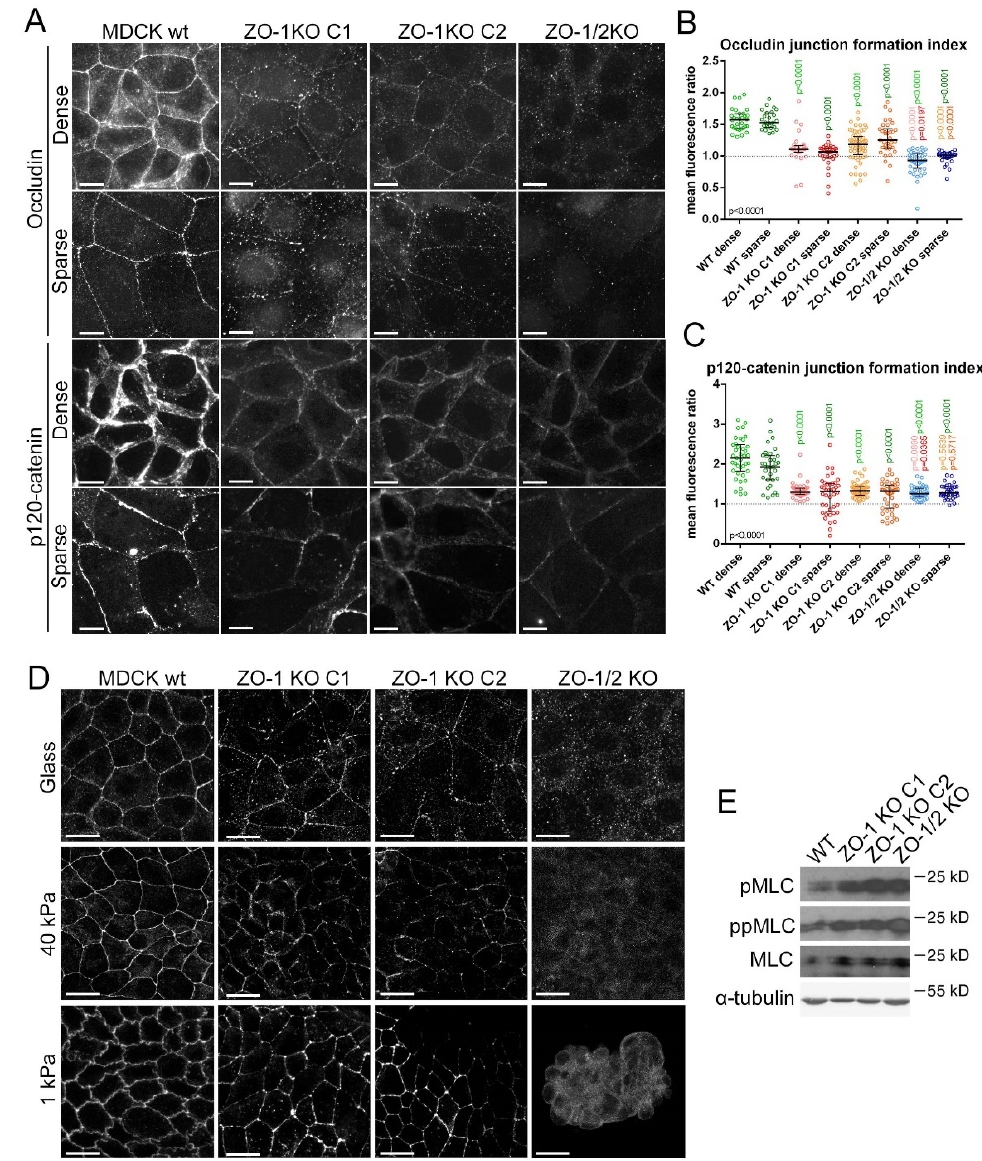
Figure 6. Non-redundant role of ZO-1 in TJ formation. ( A – C ) Wild-type and knockout MDCK cells were seeded on glass for 2 days as Figure 3 and immunostained for occludin and p120-catenin ( A ). Quantification of the ratio of junctional to cytosolic mean fluorescence intensity for single junctions was performed for occludin ( B ) and p120-catenin ( C ) on images derived from dense and sparse areas (data points represent junctions analysed). ( D ) Wild-type and knockout MDCK cells were cultured until full confluence before immunostaining for occludin. Note, the reduced junctional occludin staining in ZO-1 knockouts and the discontinuities on all ECM types. On 1kPA ECM, the double knockout cells were unable to form a continuous confluent monolayer. ( E ) Wild-type and knockout MDCK cells were analysed by immunoblotting for phosphorylated MLC. Magnification bars, 20 μ m.